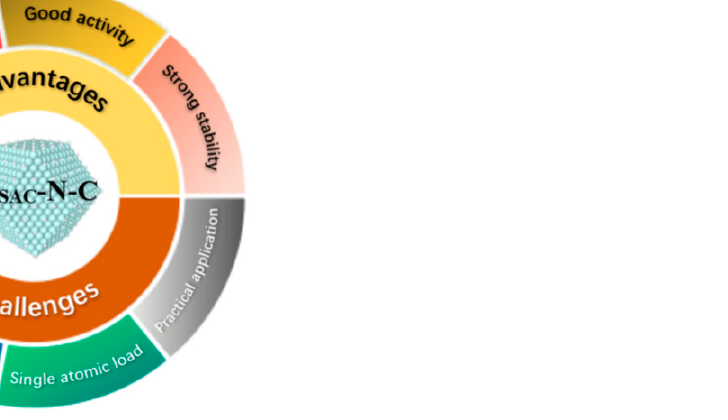
Figure 1. Summary diagram of the advantages and challenges of M SAC -N-C catalysts derived from ZIF-8 precursors.